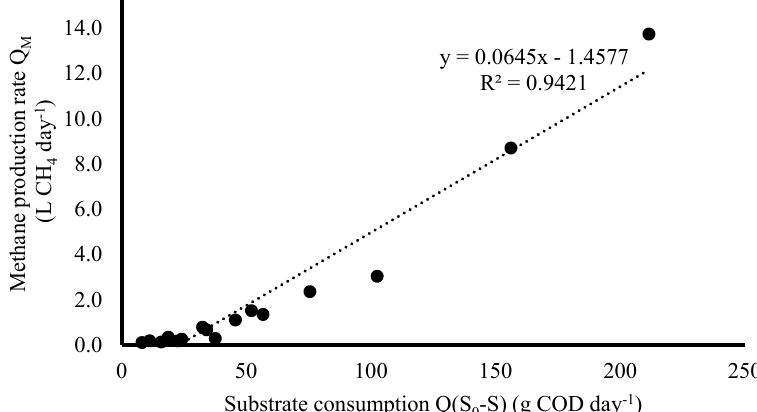
Figure 11. Methane production rate as a function of substrate consumption rate. Table 5. Summary of kinetic parameters.